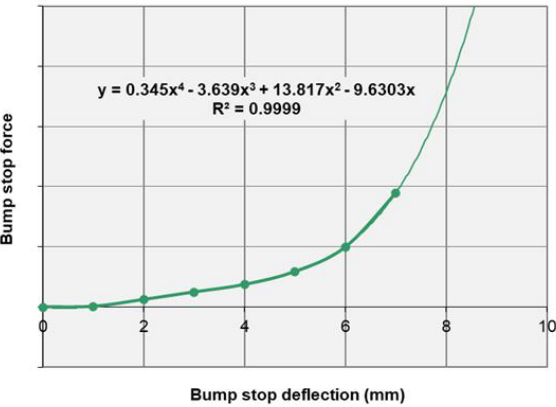
Figure 10. Typical bump stop force vs. deflection curve with “progressive” characteristics.